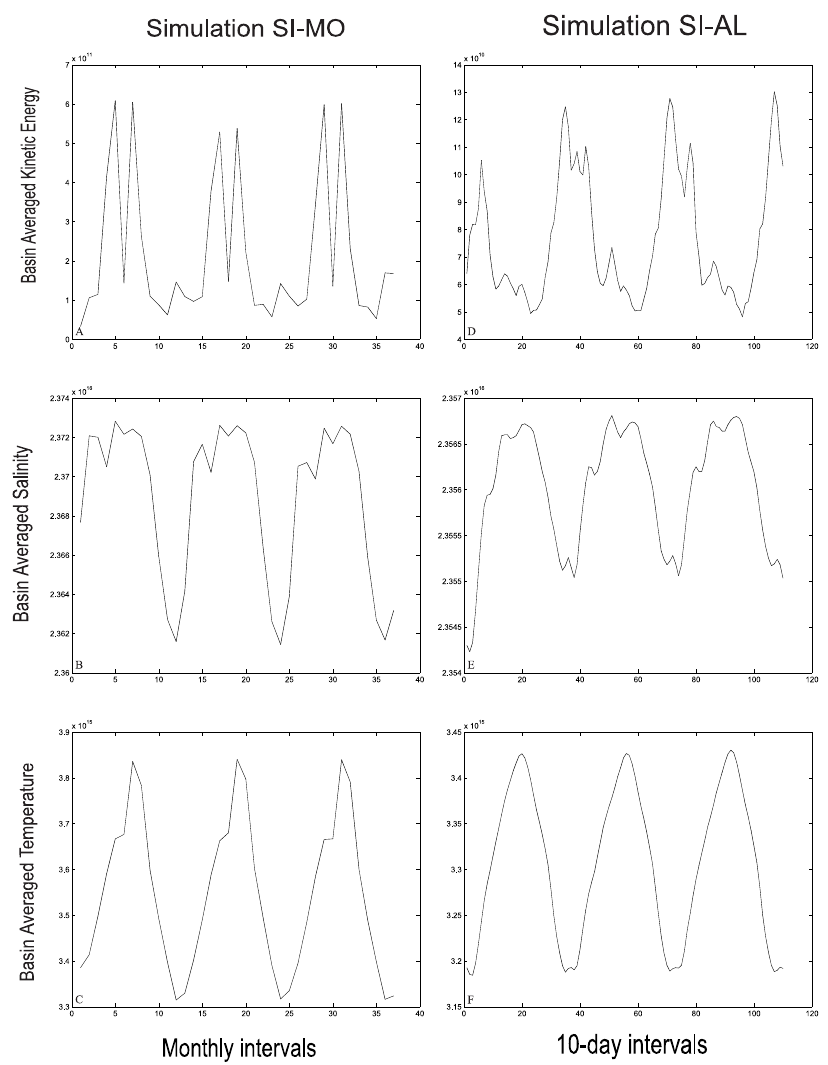
Fig. 3. Simulation SI-MO: (a) Basin averaged kinetic energy time series, (b) Basin averaged salinity time series, and (c) Basin averaged temperature time series. Simulation SI-AL: (d) Basin averaged kinetic energy time series, (e) Basin averaged salinity time series, and (f) Basin averaged temperature time